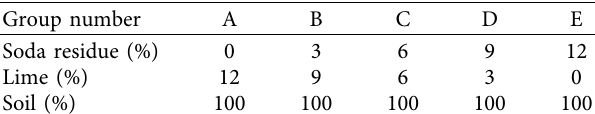
Figure 2: Mix ratio design process of SRLS materials in road base. Table 2: Test proportioning